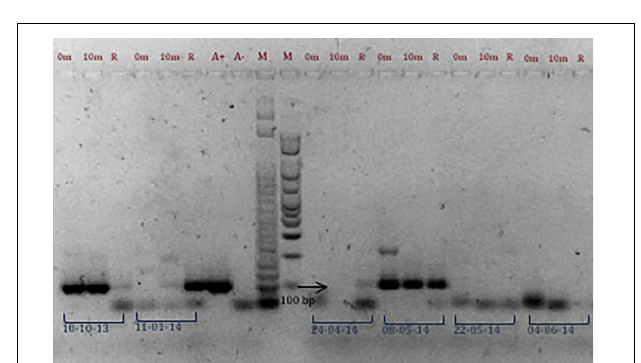
FIGURE 4 | PCR amplification of samples from Station 13 using AOF4 and AOR3 primers. The 99 bp ITS fragment indicates the presences of A. ostenfeldii . Results of samples collected at different dates are presented (October 10, 2013; November 1, 2014; April 24, 2014; May 8 and 22, 2014, and June 4, 2014). Samples were collected at 0 and 10 m discrete depth in the water column and by vertical phytoplankton net tows (R). A+: positive PCR control and A–: negative PCR control. M: molecular marker of 50 and 100 bp bioline.